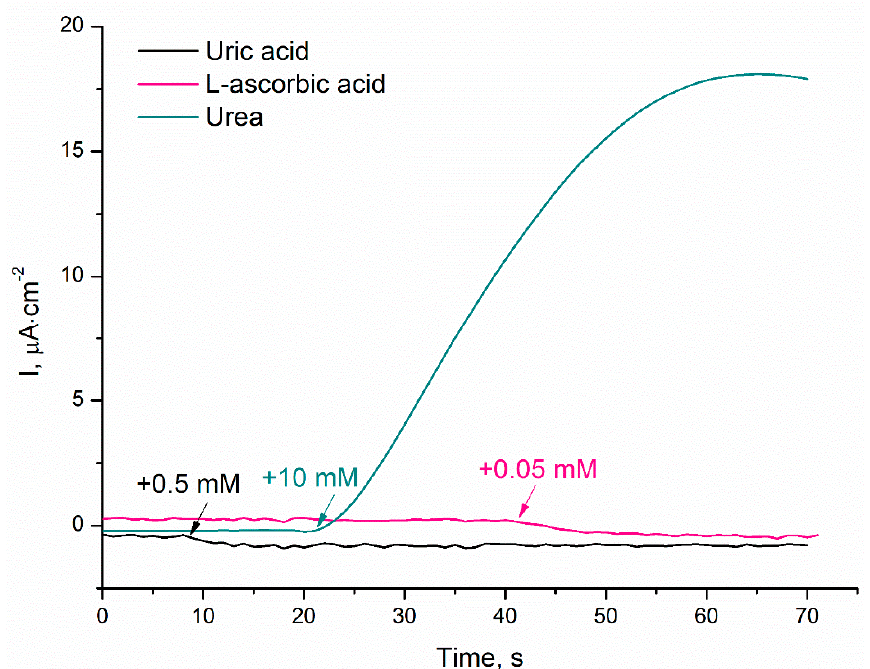
Figure 5. The current-time responses of the TRGO-based urea biosensor on addition of 10 mM of urea, 0.05 mM of L-ascorbic acid, and 0.5 mM of uric acid. Default PBS, applied electrode potential 0.2 V vs. Ag/AgCl.